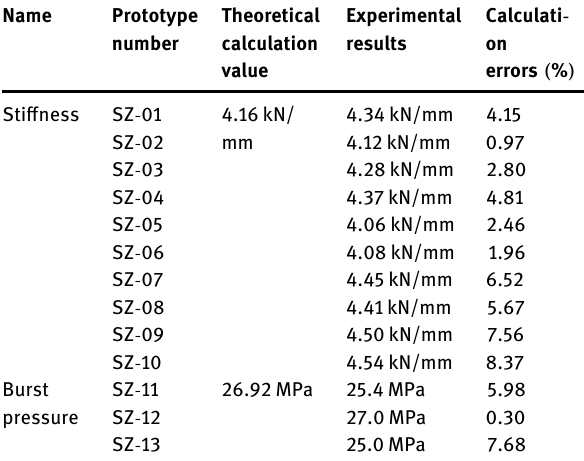
Figure 11: E ff ect of guide angles on the burst pressure.